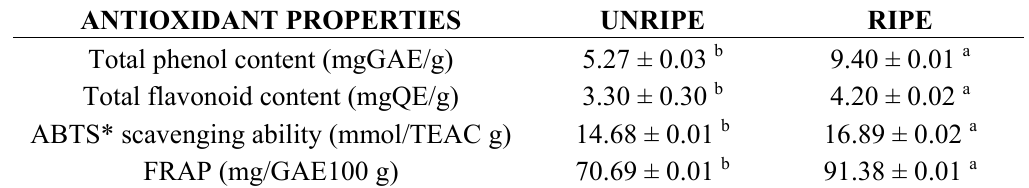
Table 3. Antioxidant properties of unripe and ripe orange peel